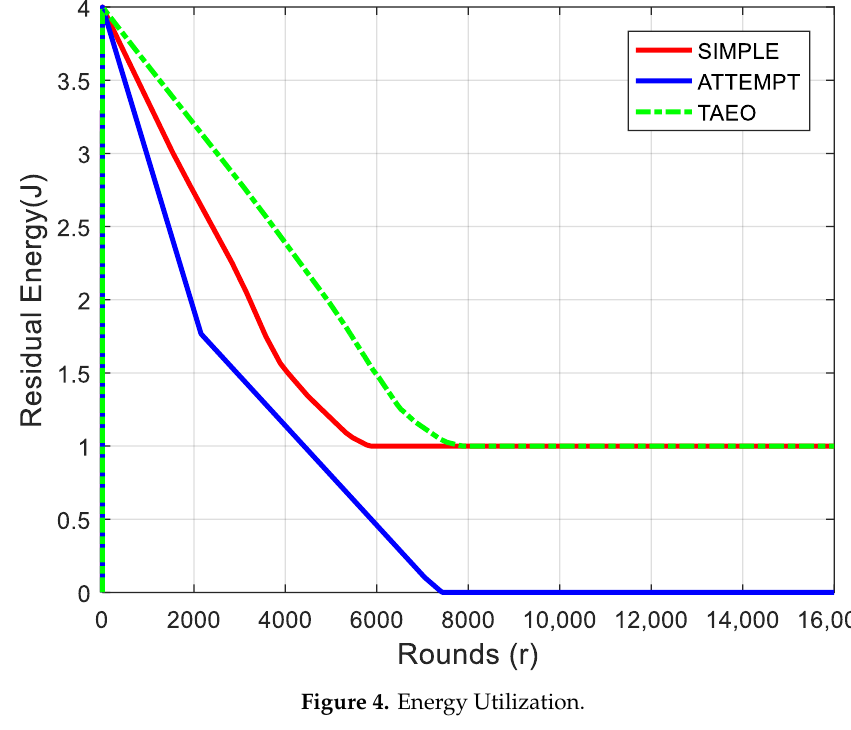
Figure 4. Energy Utilization.